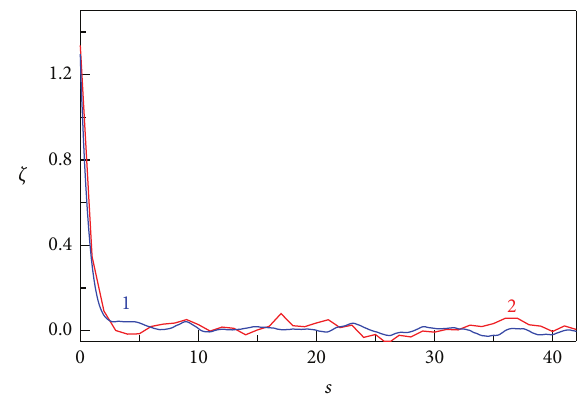
Figure 3: The illustration of the fluctuation-driven tails of the correlation function 𝜁(𝑠, 0) for the Patch 2 of the actual mirror (curve 1, blue) and for the numerically generated surface with roughness emulating the exponential correlation function with the same amplitude and the correlation radius as in Table 2 (curve 2,